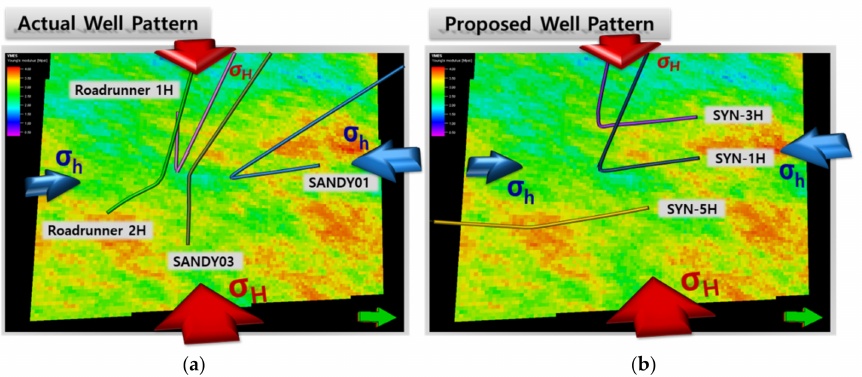
Figure 3. Hydraulic fracture treatment (HFT) models: ( a ) “Actual Well Pattern” and ( b ) “Proposed Well